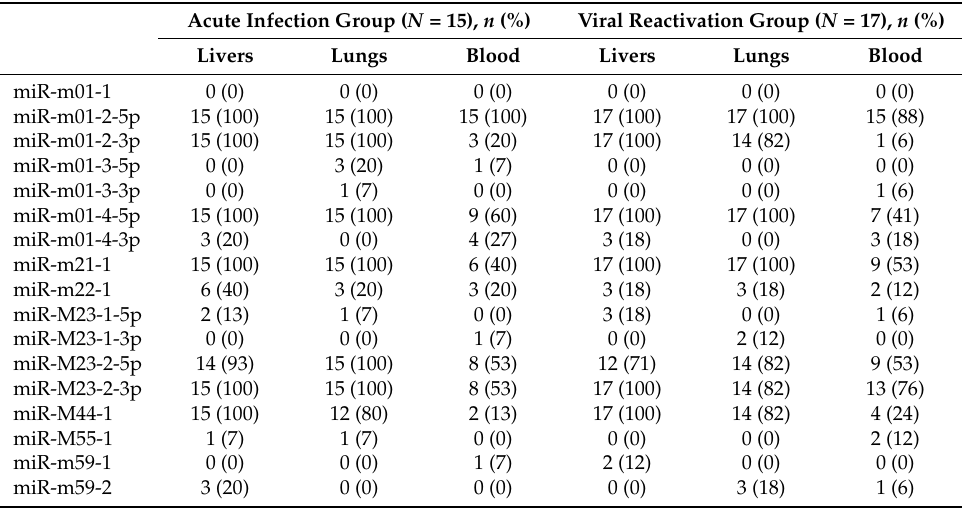
Figure 2. Expression kinetics of MCMV-encoded microRNAs (miRNAs) in vitro. Mouse embryonic fibroblasts (MEFs) were infected with MCMV, and miRNA profiles were determined using a revised real-time quantitative PCR (RT-qPCR) protocol at the indicated time points post-infection. MEFs with mock infection were used as negative controls. The results are shown as fold-change values relative to the expression levels at 72 h post-infection (hpi). Data presented are the result of three independent experiments and are shown as the mean ± standard deviation (SD). N.D.: not detected. Table 2. Viral miRNA profiles in the organs of mice suffering from acute infection or viral